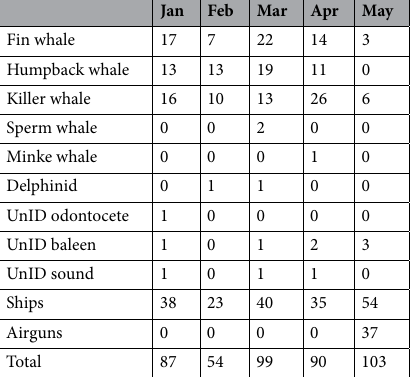
Table 1. Number of events for each detection group (whale species and anthropogenic sources) per month. UnID indicates animal groups unidentified to the species level.